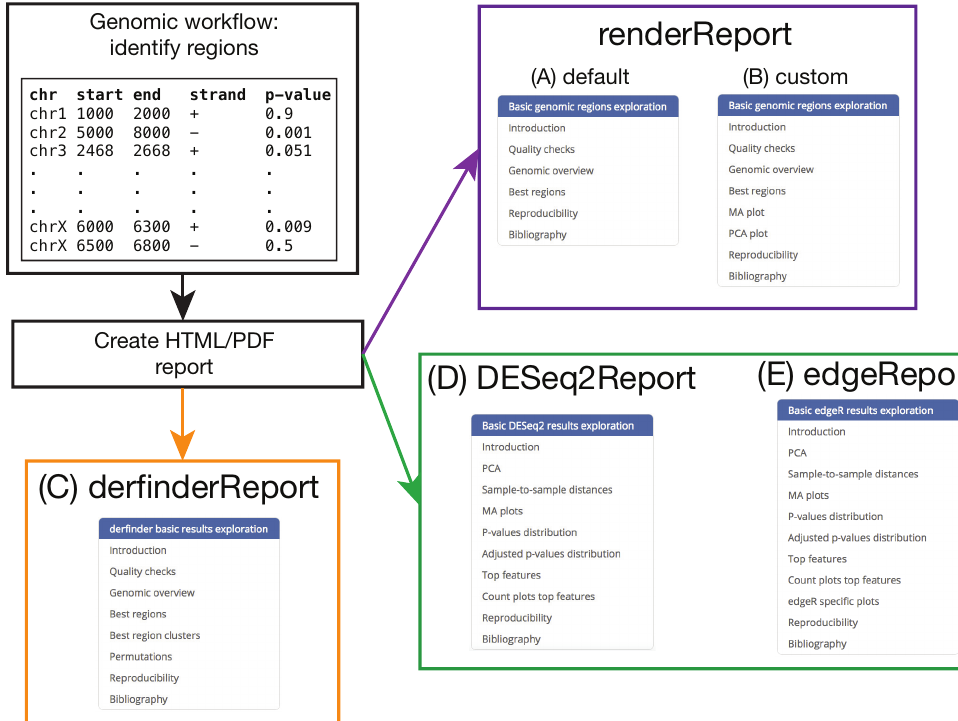
Figure 1. regionReport overview. Example region input, the appropriate regionReport function to use, and menu of the resulting report for: (A) the general use case, (B) a customised report, (C) derfinder results, (D) DESeq2 results and (E) edgeR results.